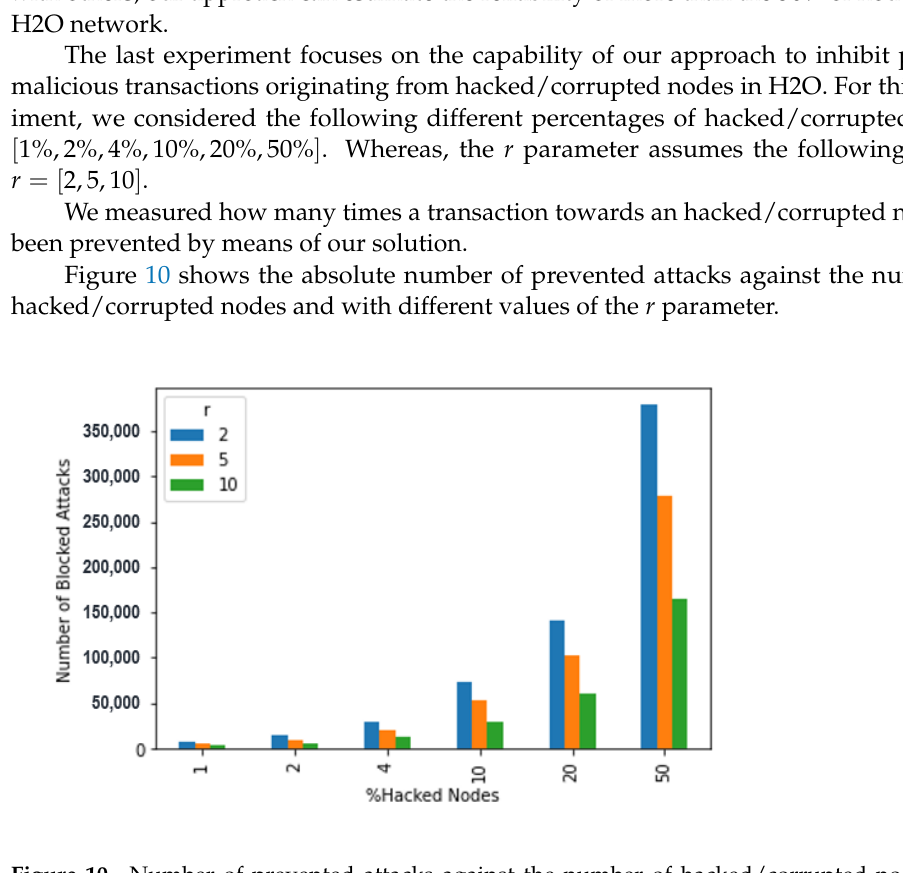
Figure 10. Number of prevented attacks against the number of hacked/corrupted nodes with different values of